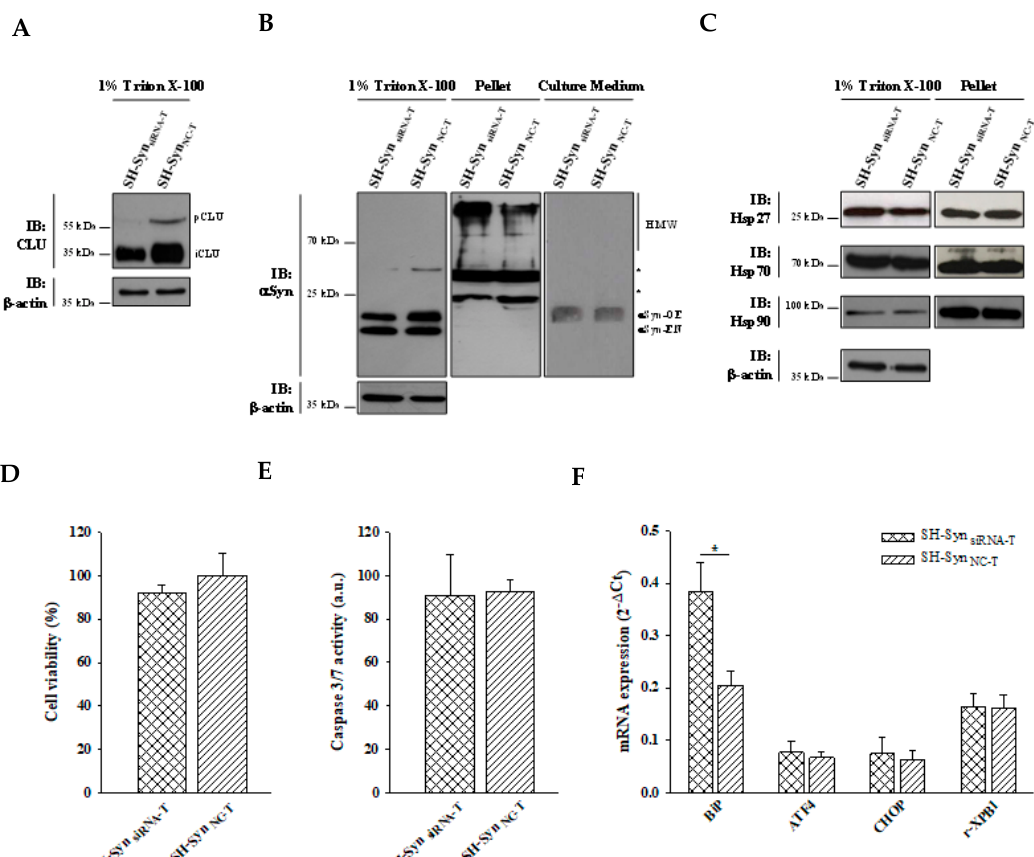
Figure 9. E ff ects of CLU down-regulation in SH-Syn T . ( A ) Detection of CLU in the 1% Triton X-100 soluble fraction of SH-Syn siRNA-T and SH-Syn NC-T . Blots are representative of experiments repeated three times. β -actin was used as the loading control. ( B ) Detection of α Syn in the 1% Triton X-100 soluble fraction, in the pellet fraction, and in the culture medium of SH-Syn siRNA-T and SH-Syn NC-T . Blots are representative of experiments repeated two times. β -actin was used as the loading control; an asterisk represents non-specific bands. ( C ) Detection of Hsp27, Hsp70, and Hsp90 in the 1% Triton X-100 soluble fraction and in the pellet fraction of SH-Syn siRNA-T and SH-Syn NC-T . Blots are representative of experiments repeated three times. β -actin was used as the loading control. ( D ) The cell viability of SH-Syn siRNA-T and SH-Syn NC-T by the WST-1 assay. Data are shown as the mean ± SD of two independent experiments, each performed in triplicate. The di ff erences between groups are not statistically significant. ( E ) Analysis of caspase 3 / 7 activity in SH-Syn siRNA-T and SH-Syn NC-T . Data are presented as the mean ± SD of two independent experiments, each performed in triplicate. The di ff erence between groups is not statistically significant. ( F ) BiP, ATF4, CHOP, and r-XBP1 mRNA quantification by qPCR in SH-Syn siRNA-T and SH-Syn NC-T . Data are presented as the mean ± SD of two independent experiments, each performed in duplicate. Data were analyzed by a Mann–Whitney Rank Sum Test (* p < 0.05).